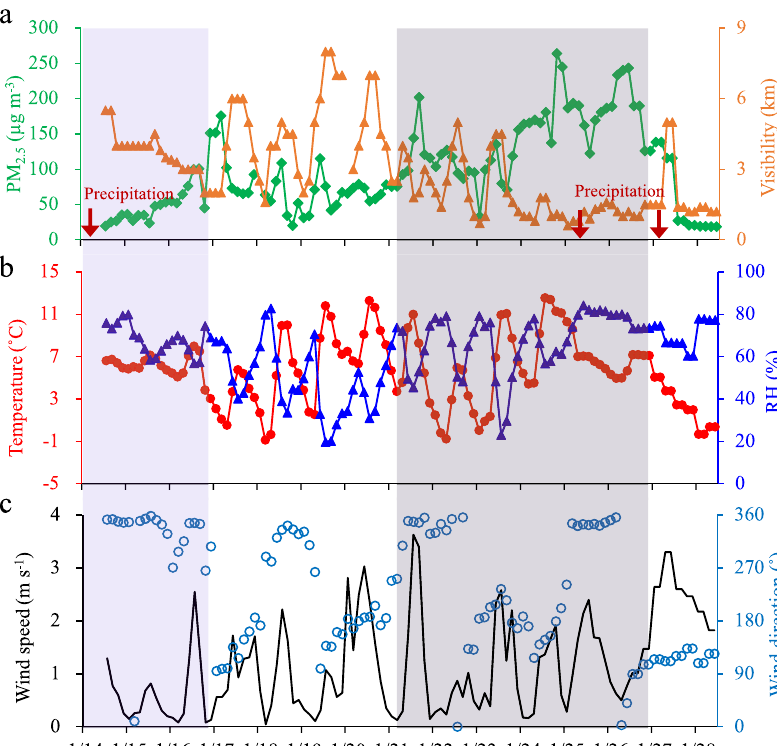
Fig. 1 Evolution of meteorological parameters and particle mass concentration during the haze event. Time series of a mass concentrations of fi ne particulate matter (PM 2.5 , green line) and visibility (orange line), b temperature (red line) and relative humidity (blue line), c wind speed (black line) and wind direction (dark blue circle) during the haze event from January 14th to January 28th, 2015. The blue rectangle represents clean period and the gray rectangle represents haze